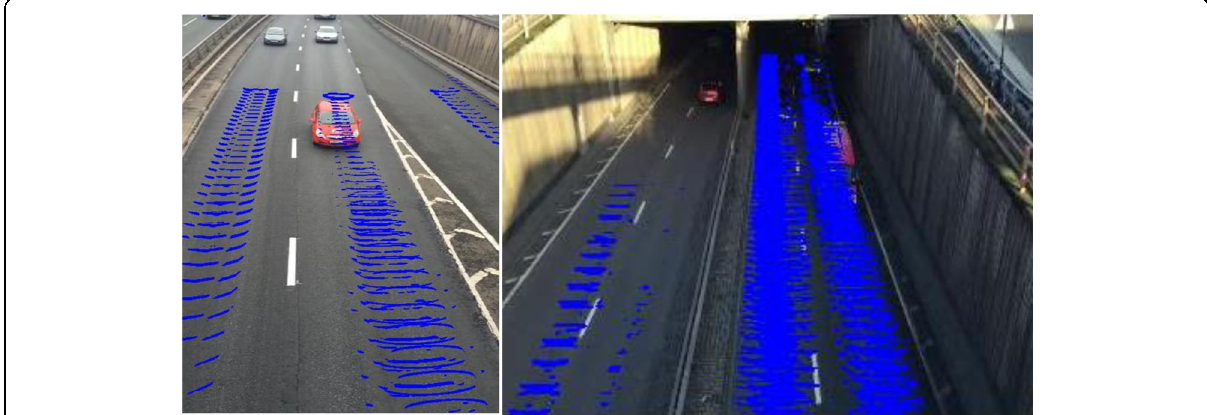
Fig. 12 Generated optical flow of